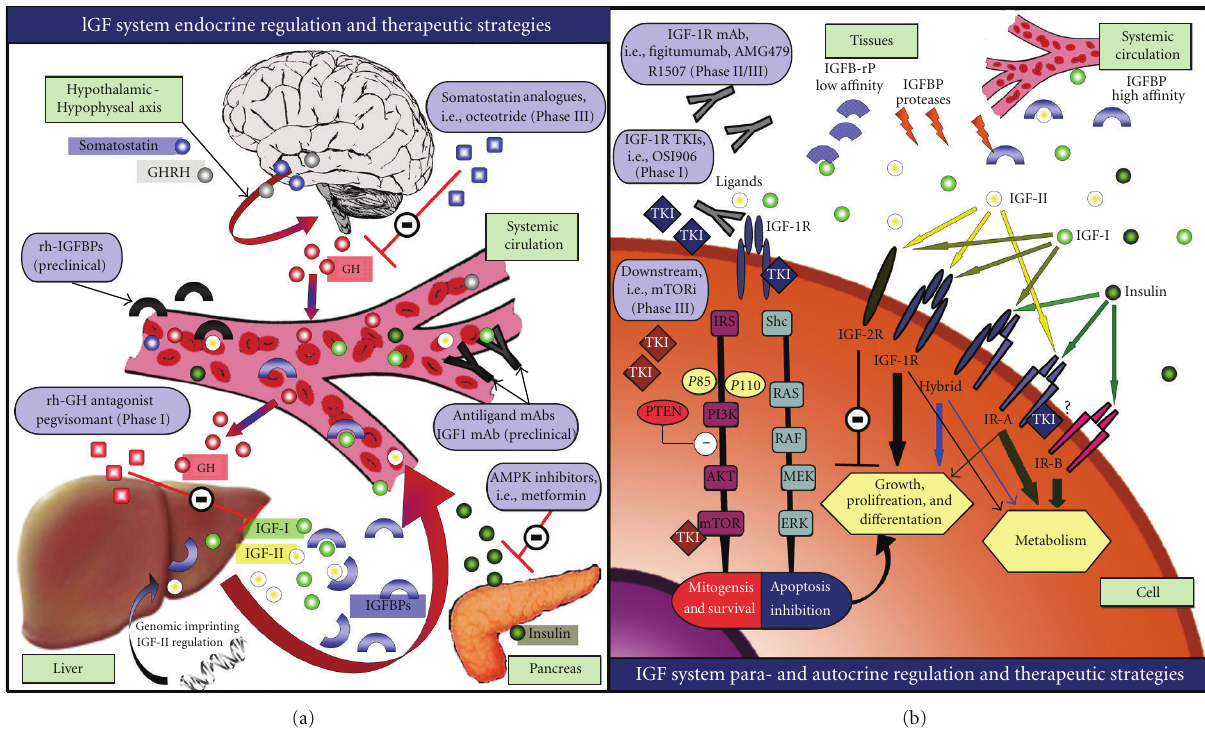
Figure 1: The endocrine, paracrine and autocrine regulation of the IGF-1R pathway and therapeutic strategies for its disruption. (a), Systemic regulation at the endocrine level. The GH-IGF-IGFBP is directed by the hypothalamus-hypophysis axis, where GH is produced, and mediated by the hypothalamus GH releasing factors (which include GHRH and somatostatins). Disruption of the hypothalamus and hypophysis axis, and thus GH release inhibition, has been attempted with somatostatin analogues (octeotride) in a Phase III trial [18]. However, this trial failed to meet the endocrinological and clinical endpoints. Pegvisomant (Pfizer) a human recombinant GH receptor antagonist, has been tested successfully for the treatment of acromegaly [19]. This pegylated recombinant human analogue of GH can decrease the production and release of IGF-I. Other strategies in preclinical development resulting in the reduction of the proportion of free ligand include antiligand mAbs [20] or recombinant IGFBPs. (b) Free-ligand levels at tissue level are also regulated by the presence of the di ff erent IGFBPs. This figure illustrates the downstream signalling cascades that result in stimulation of the cell cycle and translation, leading to increased proliferation and growth and inhibition of apoptosis. The IGF-1R pathway can be disrupted by using anti-IGF-1R mAbs and tyrosine kinase inhibitors (TKIs). Another potential strategy is represented by the inhibition of downstream intracellular tyrosine kinase proteins, that is, multiple small molecule inhibitors against PI3K, AKT, RAF, MEK, and mTOR inhibitors [21]. (Adapted from